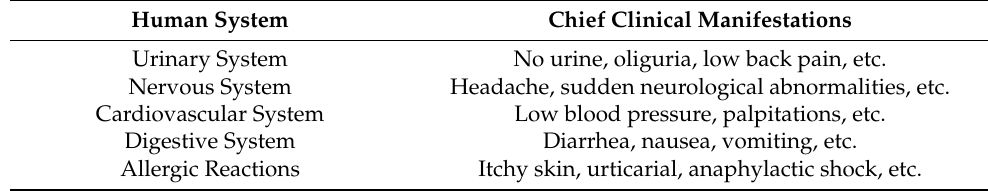
Table 3. Side effects induced by ACV.